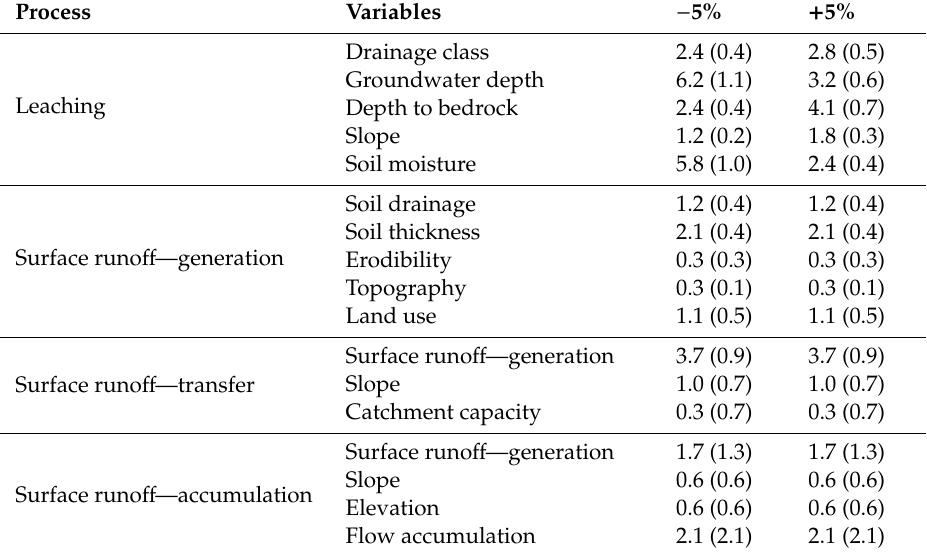
Table 4. Each process associated with pesticide fate includes a set of variables. The values represent the average change (in %) and the variation in change (in brackets) of the one-at-a-time sensitivity analysis on the variables, changing them by 5% of the original